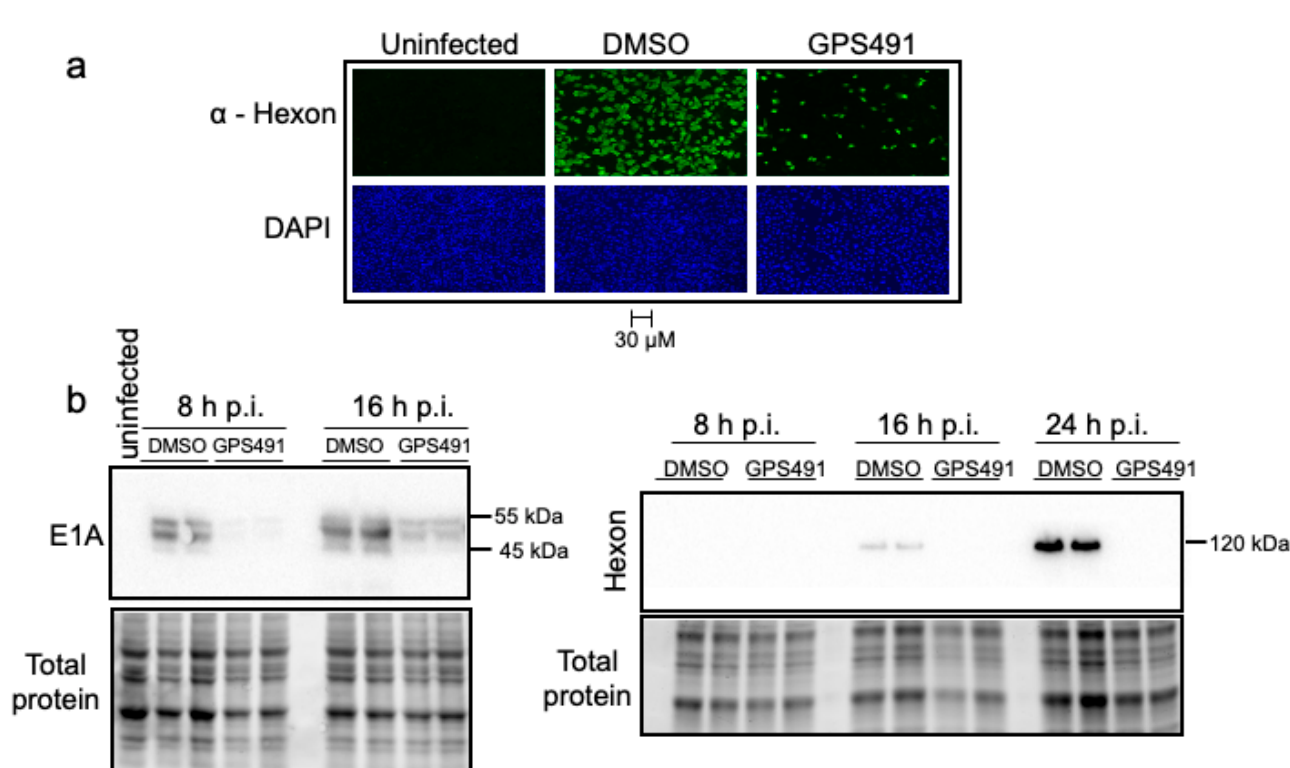
Figure 4. GPS491 delays E1A production and inhibits adenovirus hexon expression. A549 cells were infected with HAdV-C5 at an input MOI of 100 IU/cell for 1 h after which the virus inoculum was removed and replaced with media containing DMSO or GPS491 (2.5 µM). ( a ) Cells were fixed 24 h after infection and hexon expression assessed by immunofluorescence. Scale is the same for all images. ( b ) Cells were harvested 8 h, 16 h, or 24 h p.i. and lysates were fractionated on SDS-PAGE gels. Shown are the representative Western blots showing the expression levels of E1A and hexon proteins in the control versus treated lysates.